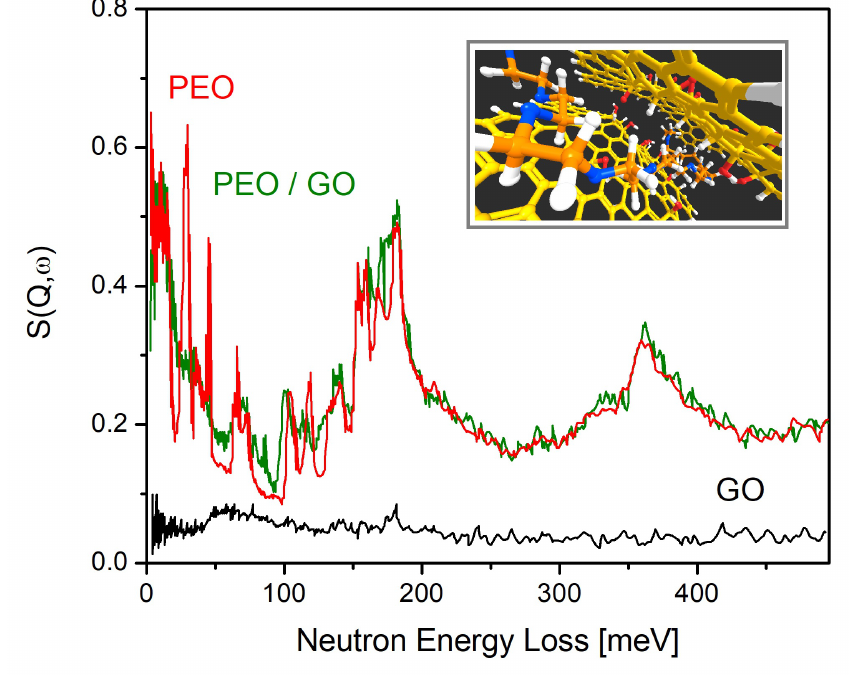
Figure 7. INS spectra of bulk (red) and confined (green) PEO. The black trace corresponds to the INS response of the graphite oxide substrate. Adapted from Ref. [202] with permission from The Royal Society of